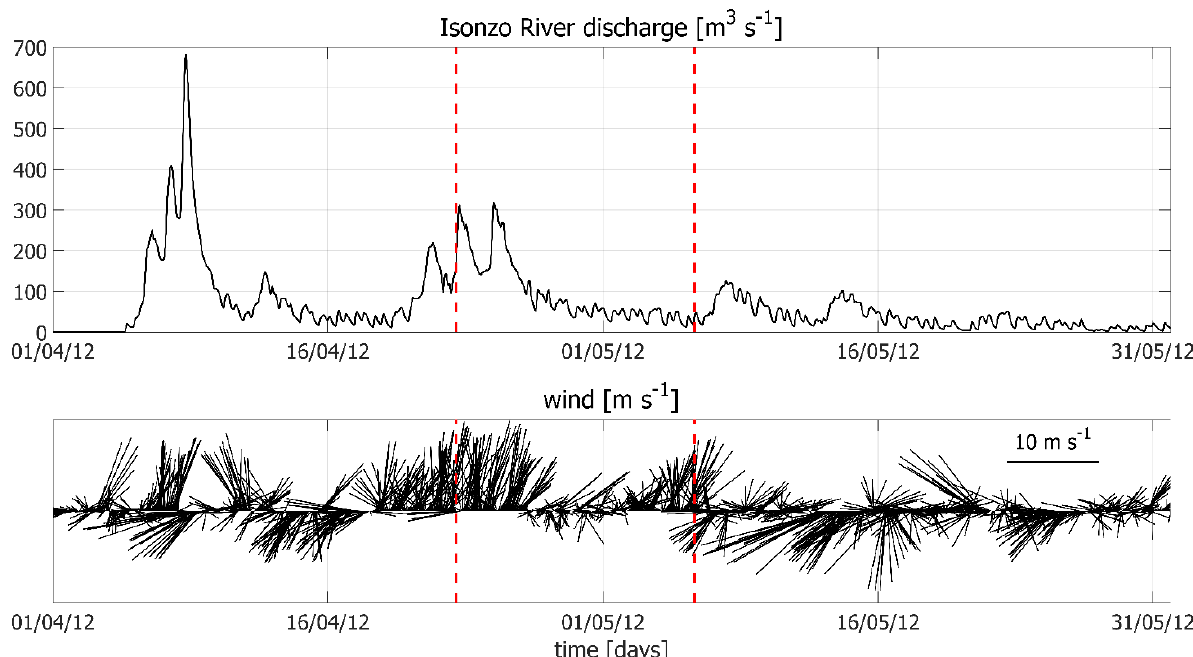
Figure 2. Isonzo river discharge (top panel) and wind regime (bottom panel) in April and May 2012. The wind diagram adopts the oceanographic convention: sticks point to the direction where the air is moving to. River flow rates were derived from in-situ measurements, while wind vectors were extracted from the ALADIN model fields, sampled in the center of the basin. The beginning and the end of the TOSCA experiment are marked by the red dashed lines.